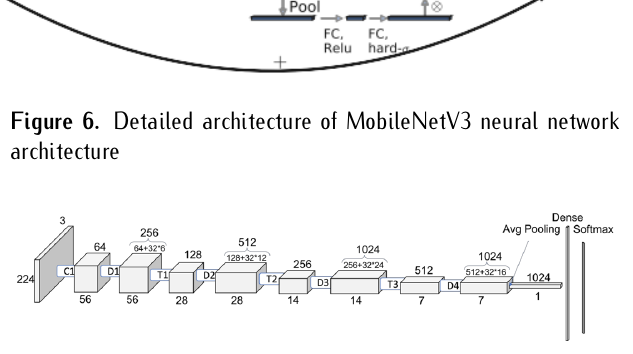
Figure 7. Detailed architecture of DenseNet-121 architecture neural network architecture